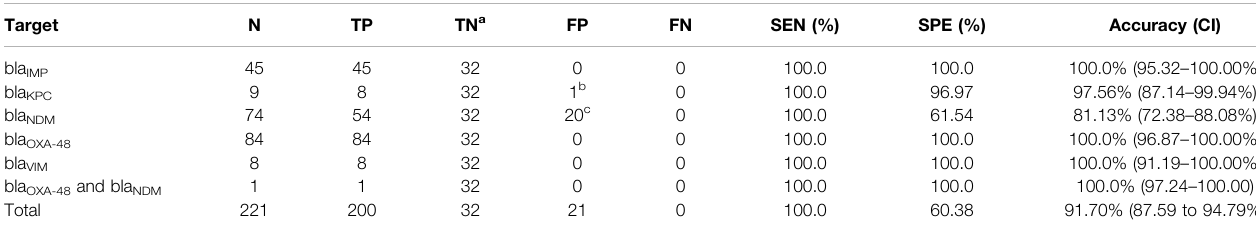
TABLE 4 | Classi fi cation of clinical isolates when using the ML-based MCA method. Target